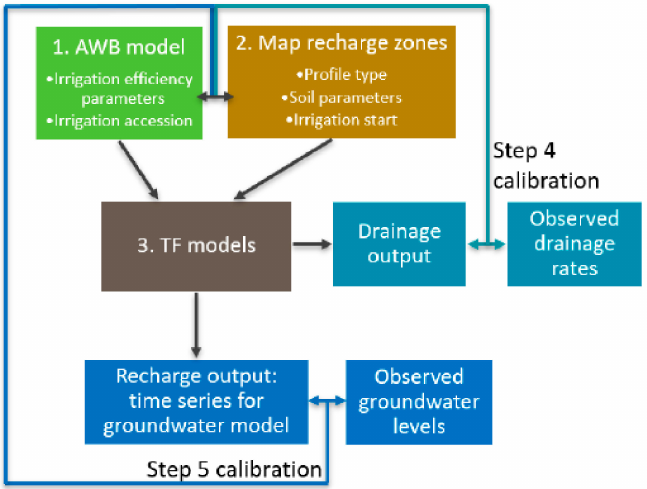
Figure 3. Process used in the integrated modelling